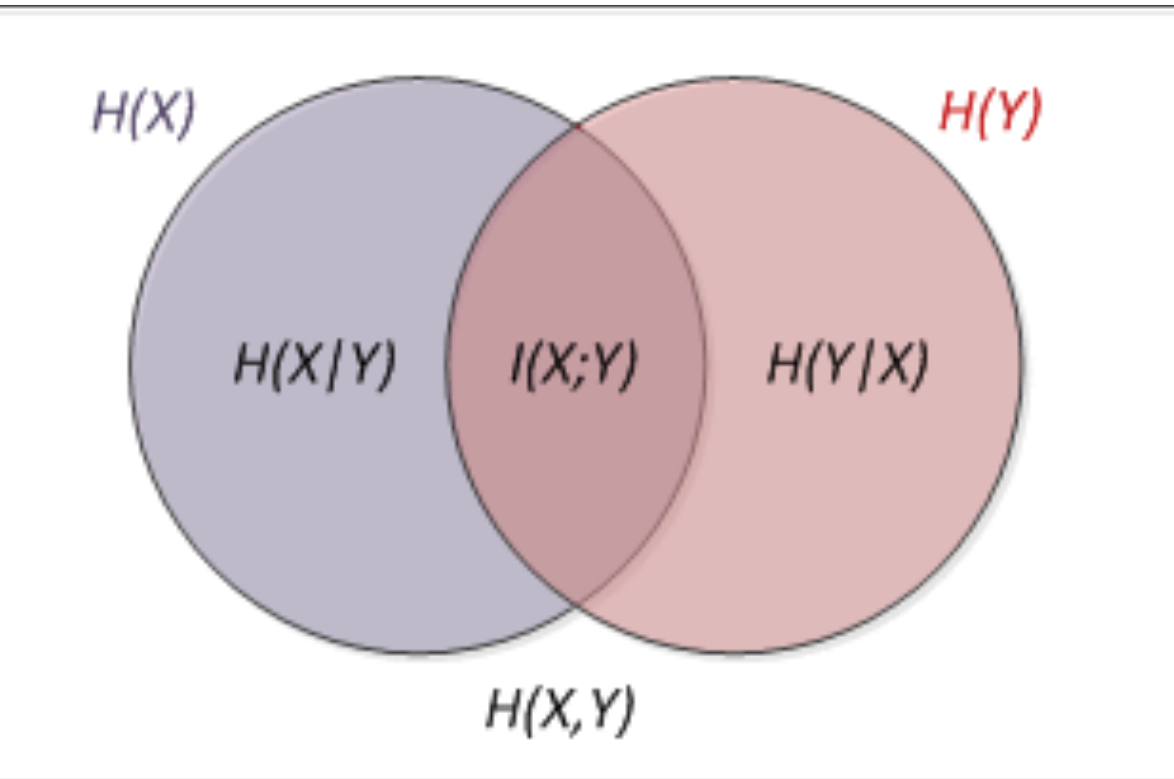
Figure 2. Individual conditional entropies and mutual information for a pair of correlated